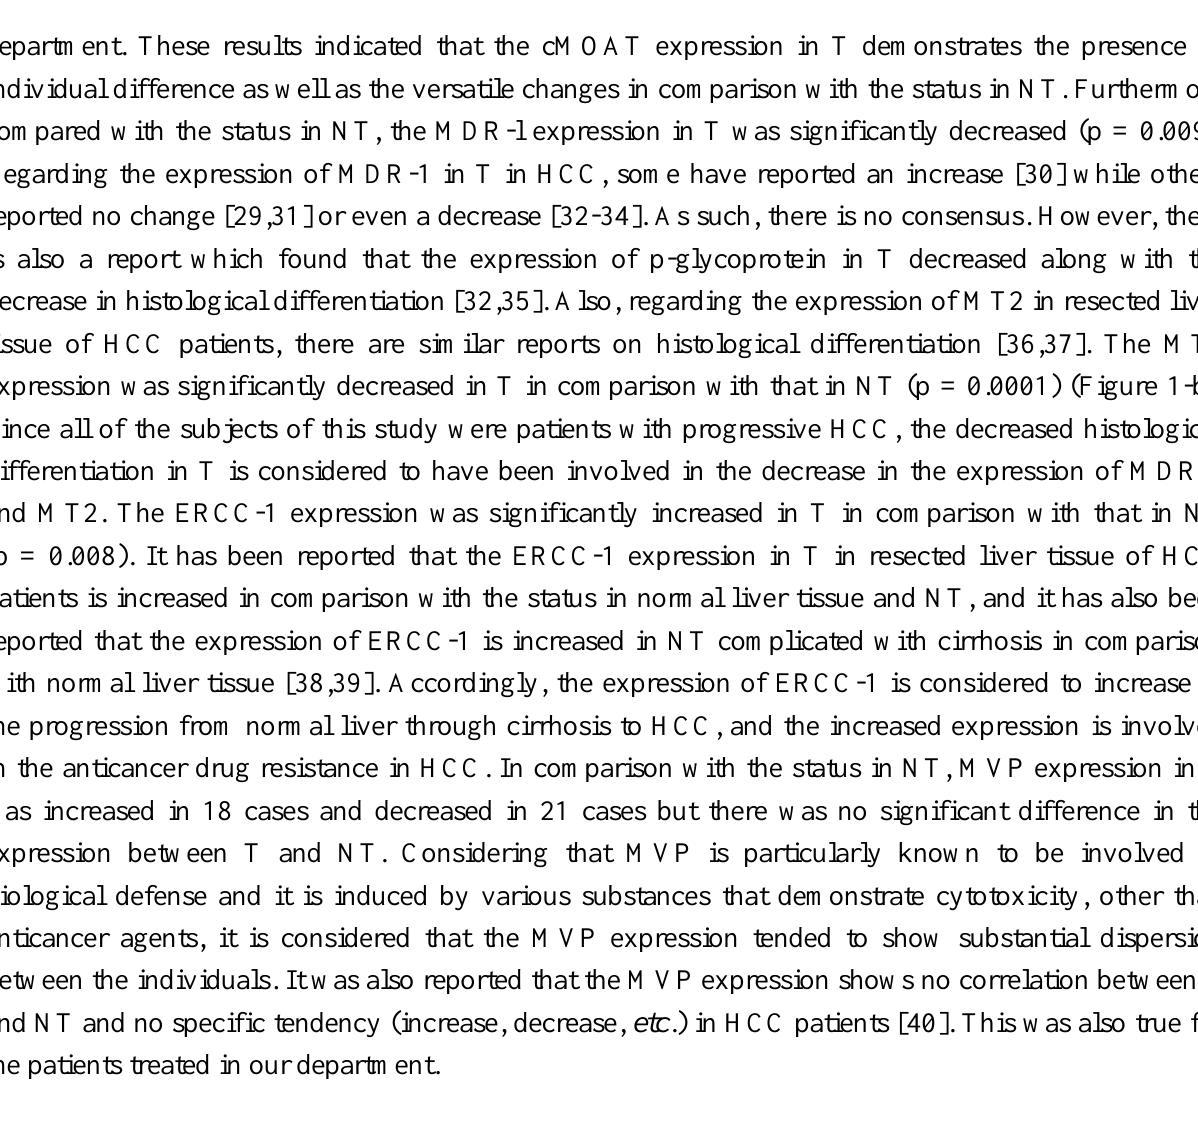
Table 3. mRNA expression of each resistance factor gene in T and